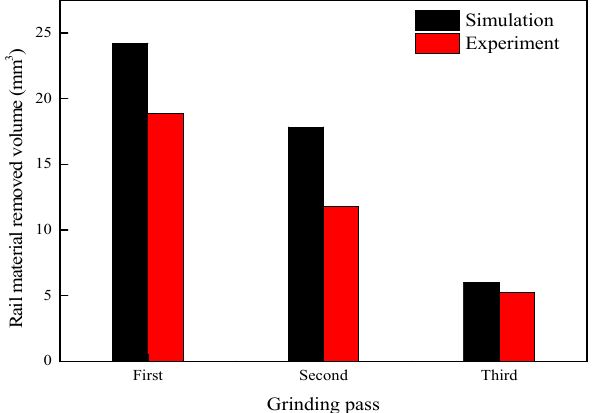
Figure 7. Change in the volume of removed rail material with the number of grinding passes in the simulation and the experiment.